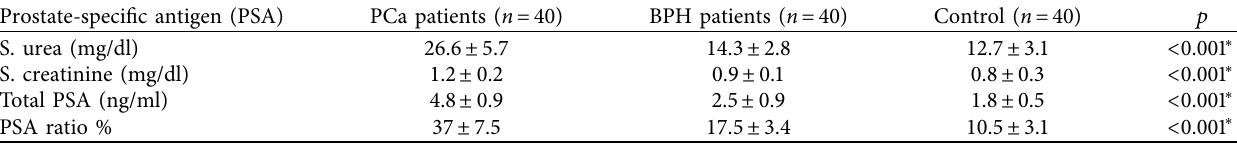
Table 1: Comparison of PSA levels of the affected and the control groups.